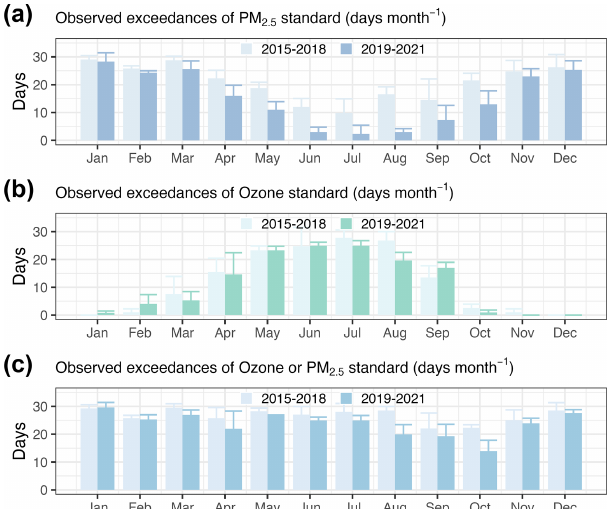
Figure 1. Observed exceedance frequency (in days per month) of PM 2 . 5 (a) , ozone (b) , and ozone or PM 2 . 5 (c) standard (NAAQS level-1) in the biggest city (i.e., Xi’an) in the Fenwei Plain, averaged over 2015–2018 and 2019–2021. Ozone and PM 2 . 5 were averaged from 13 monitoring sites in Xi’an. Error bar represents 1 standard